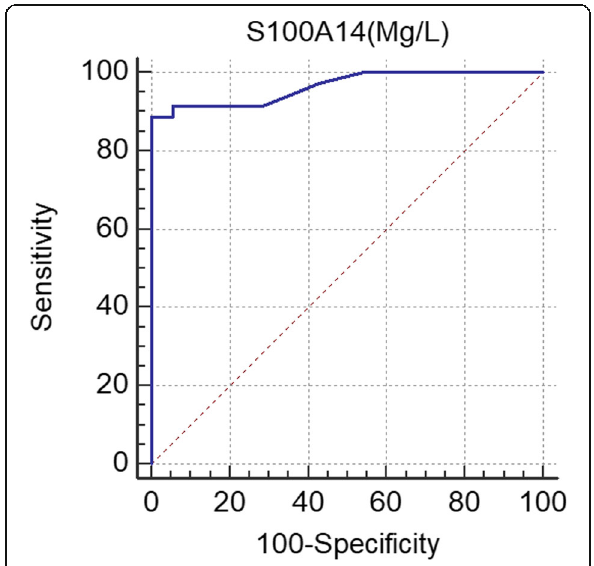
Fig. 1 ROC of S100A14 in HCC group and cirrhosis group